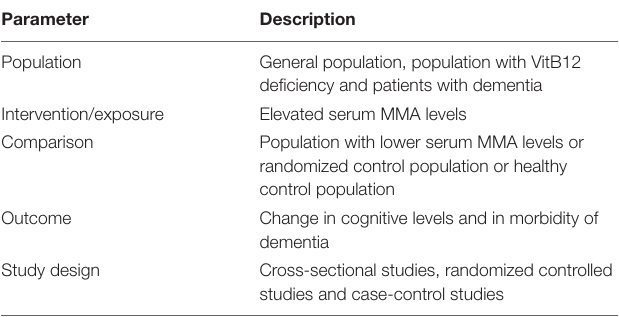
TABLE 1 | PICOS criteria for inclusion and exclusion of studies.